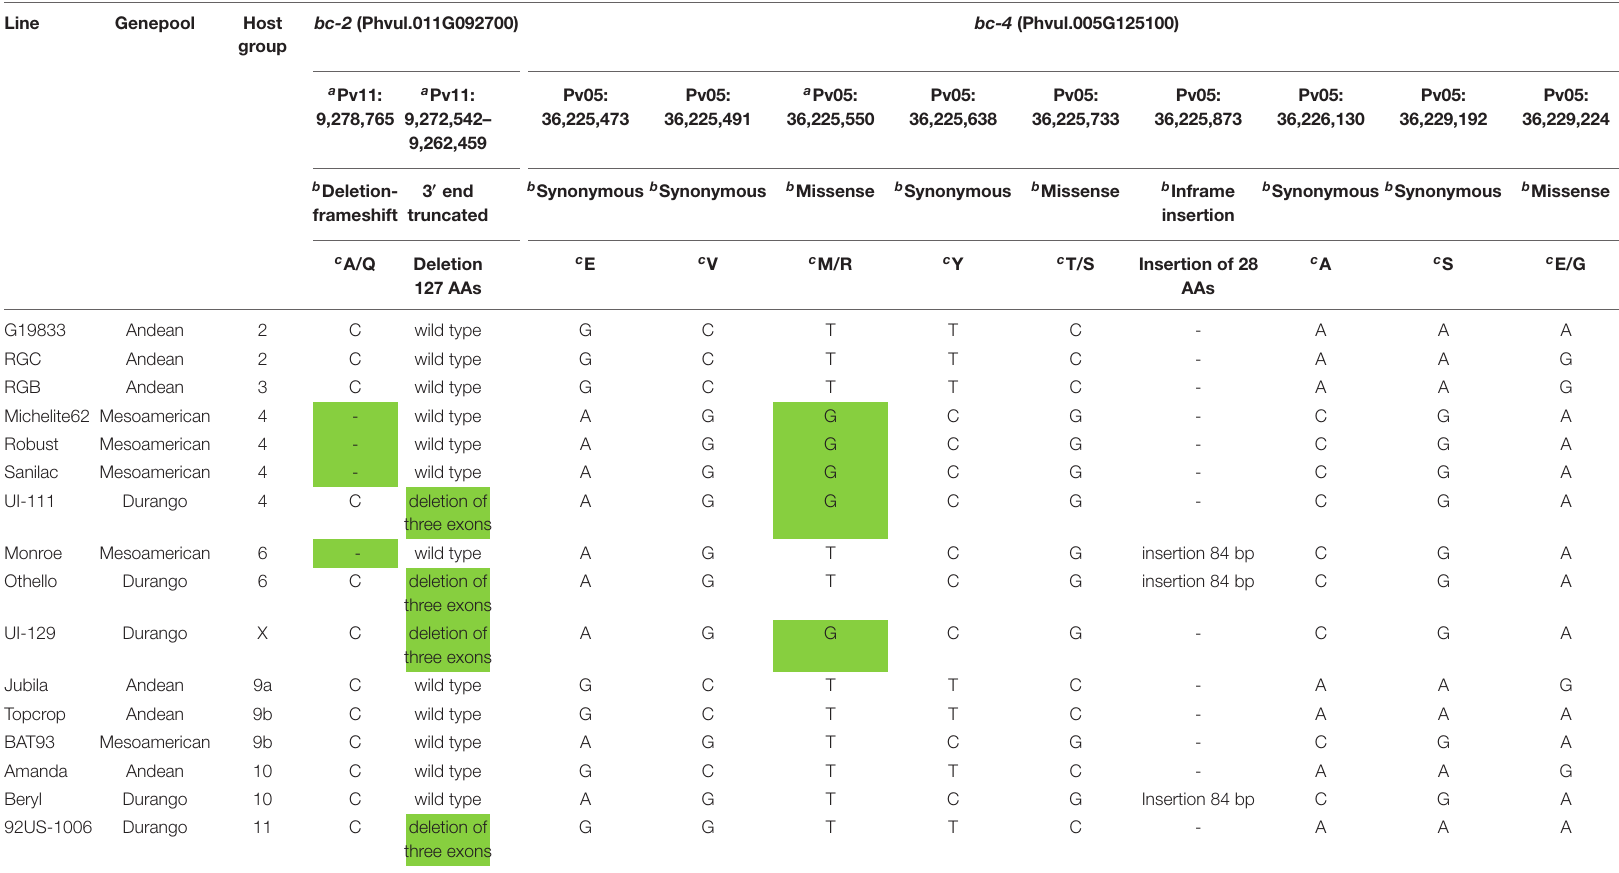
a Candidate variant for marker-assisted selection, with mutant allele shaded light green. b Variant type. c Amino acid substitutions in protein-coding